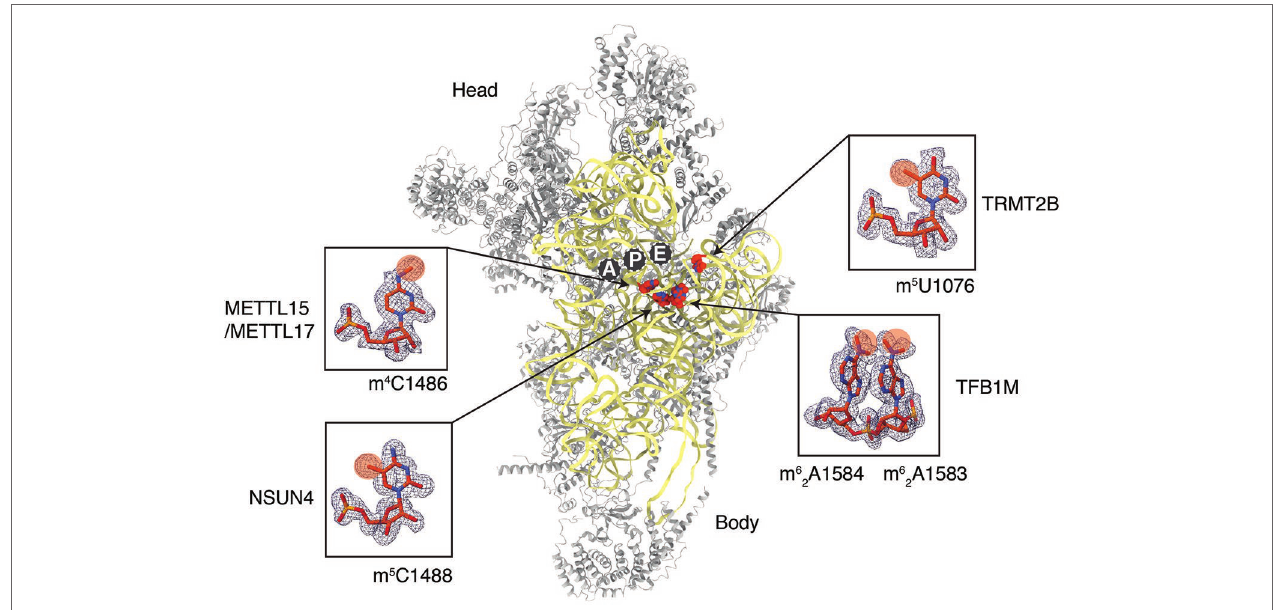
FIGURE 2 | Methylated 12S mitoribosomal rRNA (mt-rRNA) residues in the human mitoribosomal small subunit as revealed by cryoEM. The structure of human 28S (PDB: 6RW4) reveals the distribution of 12S rRNA methylation sites (red). The proteins of the 28S are colored gray and the 12S mt-rRNA is in yellow. The zoom- in panel displays the methylated rRNA residues with corresponding density maps. Chemical groups that are added enzymatically through the action of specific enzymes are highlighted in